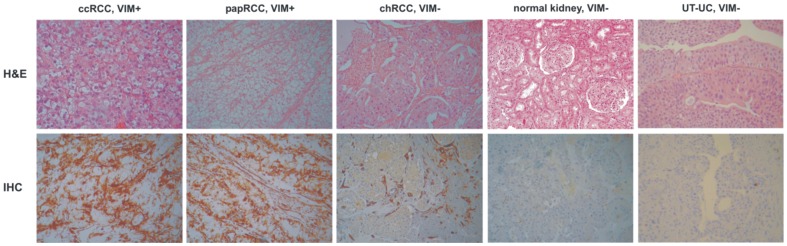
Haematoxylin and eosin (H&E) staining and immunohistochemistry (IHC).
Upper pannel: Representative H&E staining from ccRCC, papRCC, chRCC and normal kidney tissue. About 5–10 serial tissue sections of 10 μm were cut from each FFPE block, deparaffinized with xylene, hydrated and stained with H&E before microscopic examination. When the proportion of tumour cells was >70% the FFPE block was subjected to total RNA extraction. Lower pannel: IHC of FFPE tissue sections using anti-vimentin as primary antibody. Vimentin was predominantly seen in ccRCC and papRCC (∼70% and ∼50%, respectively), but only rarely in chRCC (4%) and absent in the normal kidney. Vimentin was also down-regulated in the majority of UT-UC cases.